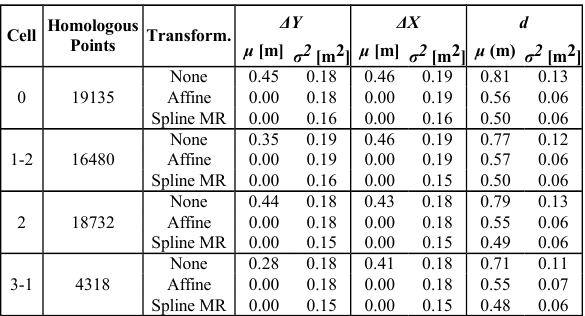
Table 1. Statistics on the homologous pairs detected in the four cells